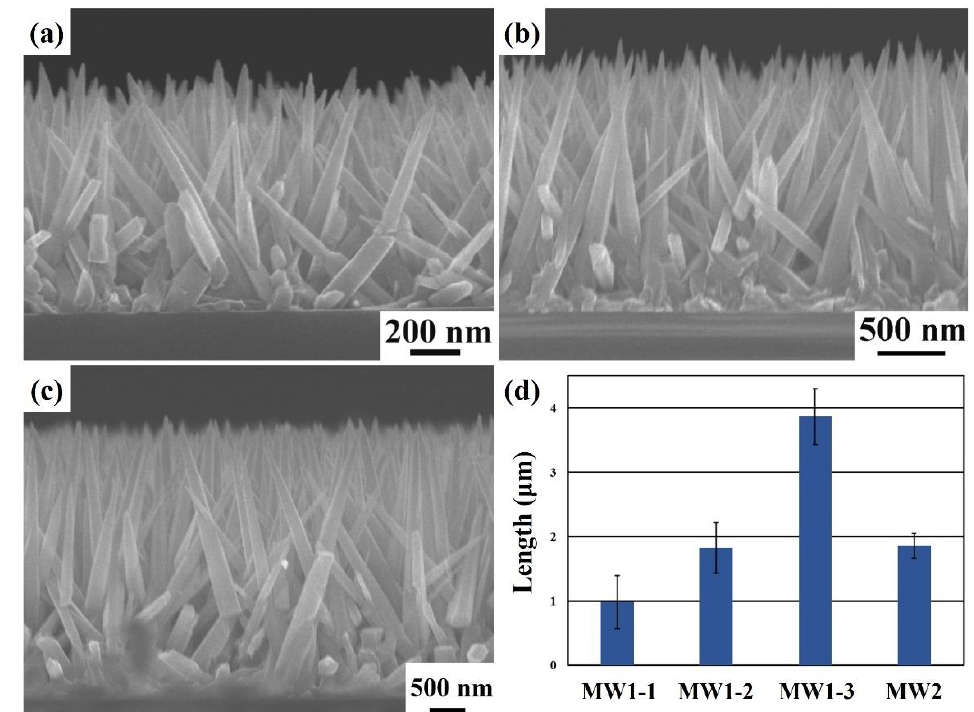
Figure 5. ( a – c ) The cross-sectional FESEM images of the ZnO nanoneedle arrays were fabricated on the silicon substrates with the ZnO seed layer at the different optimized temperature programming steps. ( d ) The average lengths of ZnO nanoneedle arrays at different temperature programming steps (MW1-1, MW1-2, MW1-3, and MW2).